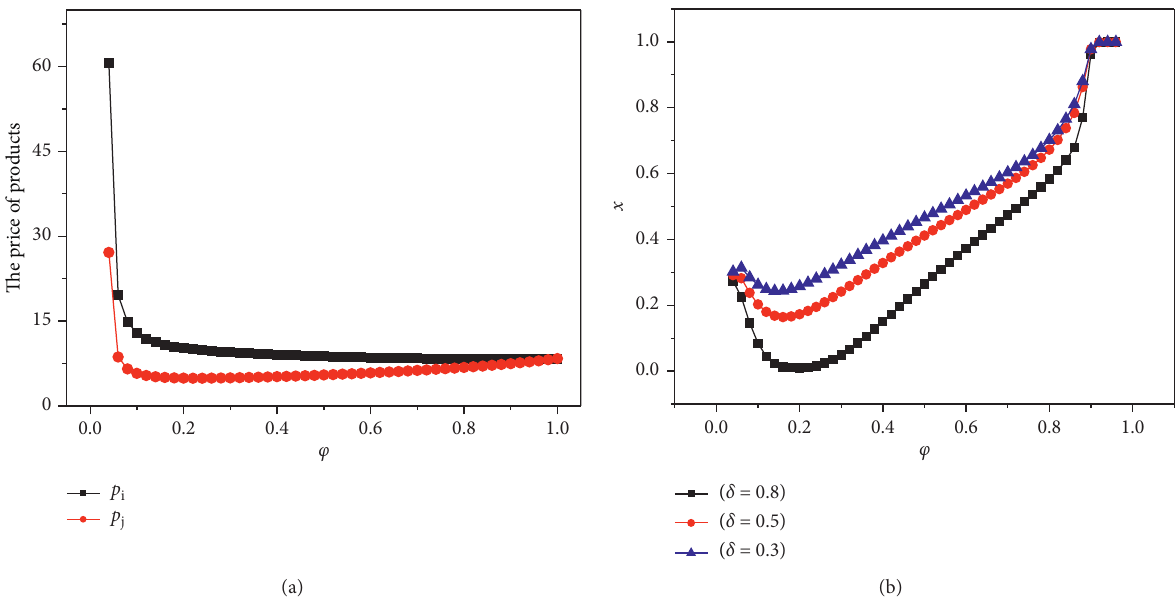
Figure 10: (a) The prices of products between innovation-leading firms and imitation-following firms for different consumers’ price preference φ with the innovation risk δ � 0.5 and (b) the relationship between the proportion of innovation-leading firms in the group and different consumers’ price preference φ on three levels of the innovation risk δ based on the improved game